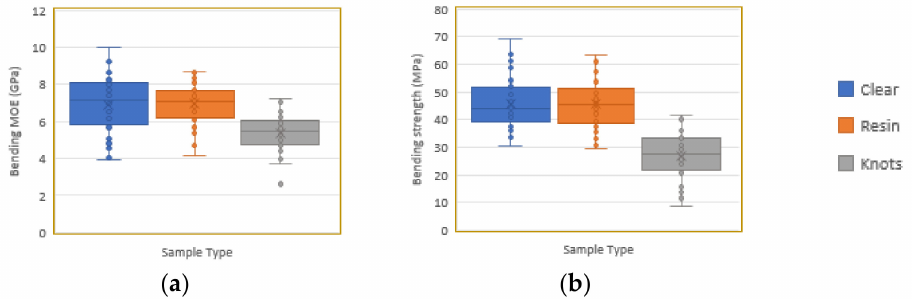
Figure 9. Box plots of ( a ) Bending MOE and ( b ) bending